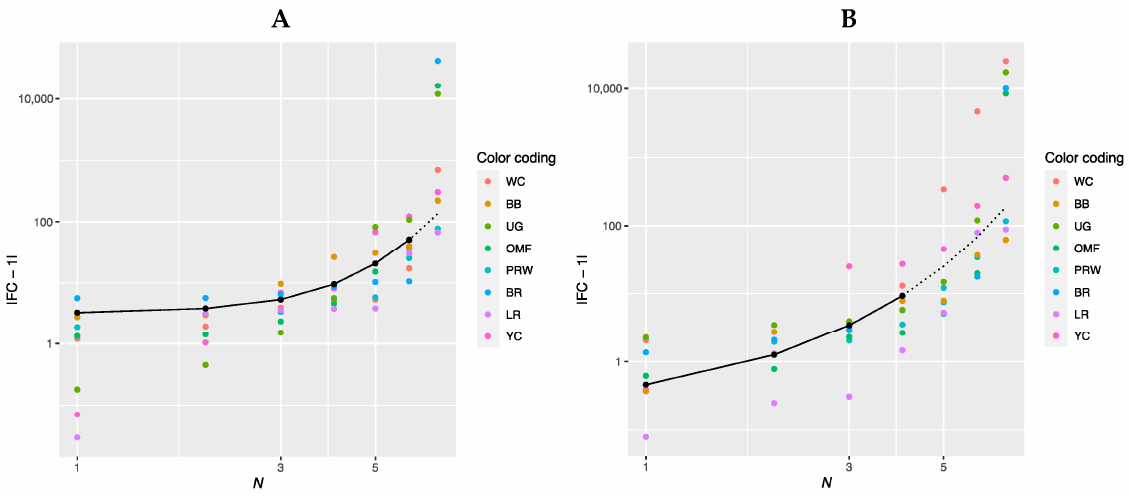
Figure 1. Log–log plots of a linear regression model for gene expression data (Table 2) in the eight breeds by muscle type (shown by a solid line). ( A ) Breast muscles ( N = 1…6); |FC − 1|( N ) = 0.12962 × exp( N ); adjusted R 2 = 0.5485. ( B ) Thigh muscles ( N = 1…4); |FC − 1|( N ) = 0.16990 × exp( N ); adjusted R 2 = 0.4220.